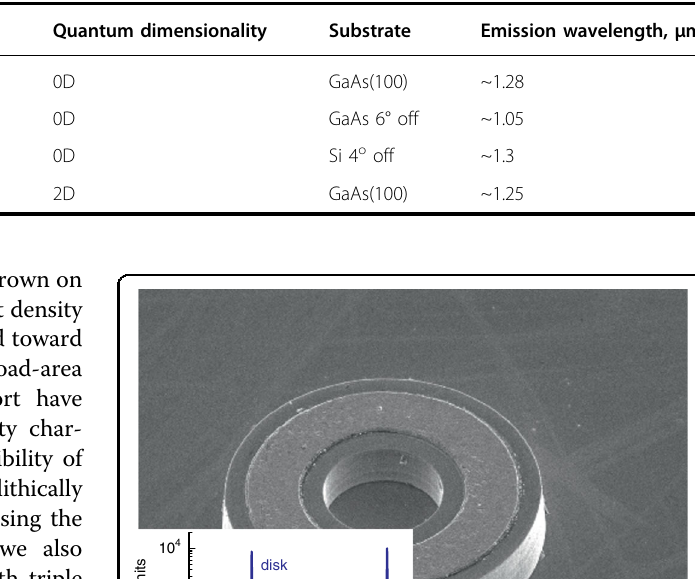
Table 1 Summary of microlasers